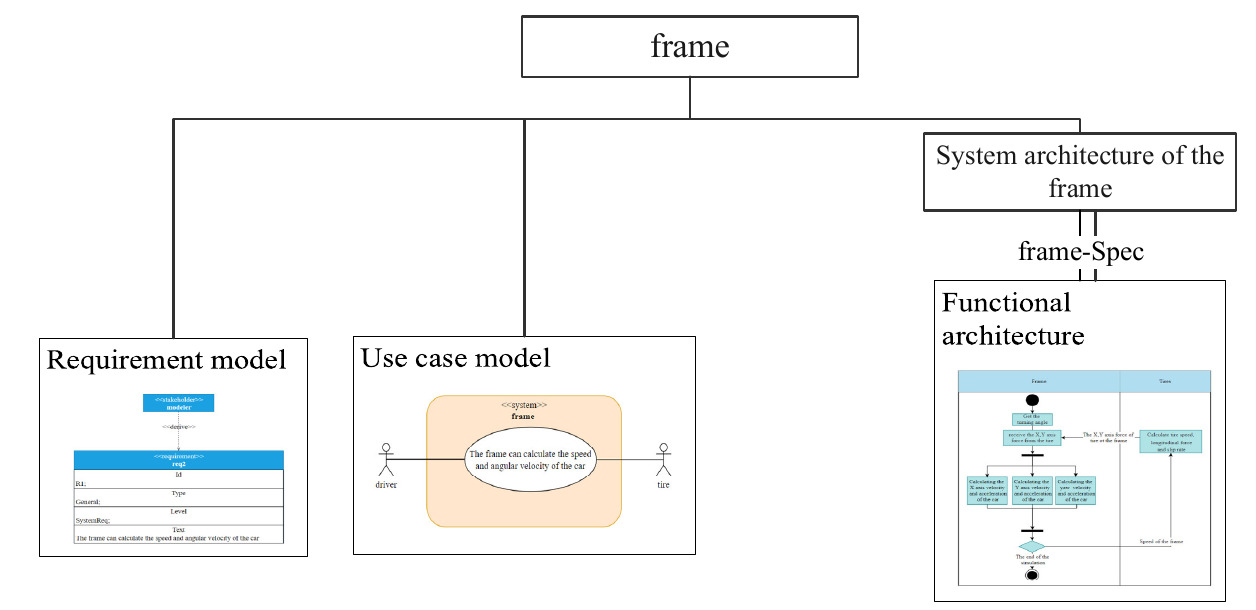
Figure 9. The SES-X Model of The Frame.